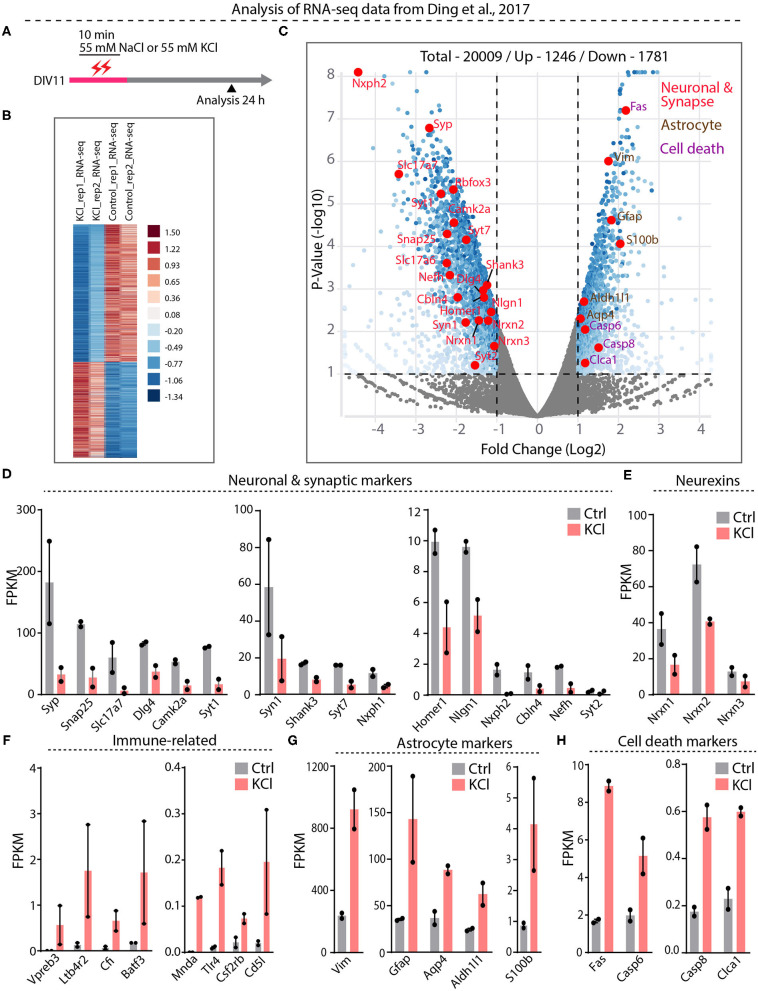
RNA-seq analysis from Ding et al. datasets show significant downregulation of neuronal and synapse markers and upregulation of cell death markers. (A) Experimental paradigm used in Ding et al. study, where 55 mM KCl or NaCl was treated on DIV11 for 10 min and samples collected at 24 h for RNA-seq analysis. (B) Heatmap show differential gene expression between duplicate KCl and control samples (C) Valcano plot showing Log2 fold change of up and down regulated genes. Key synaptic and neuronal markers highlighted in red, enrichment of astrocyte markers in brown and cell death markers in purple. (D–H) Individual FPKM-values for neuronal and synaptic markers show down regulation in KCl treated compared to control groups (D), down regulation of all Nrxns (E), up regulation of immune-related genes (F), enrichment of astrocyte markers (G), and upregulation of key cell death markers (H).